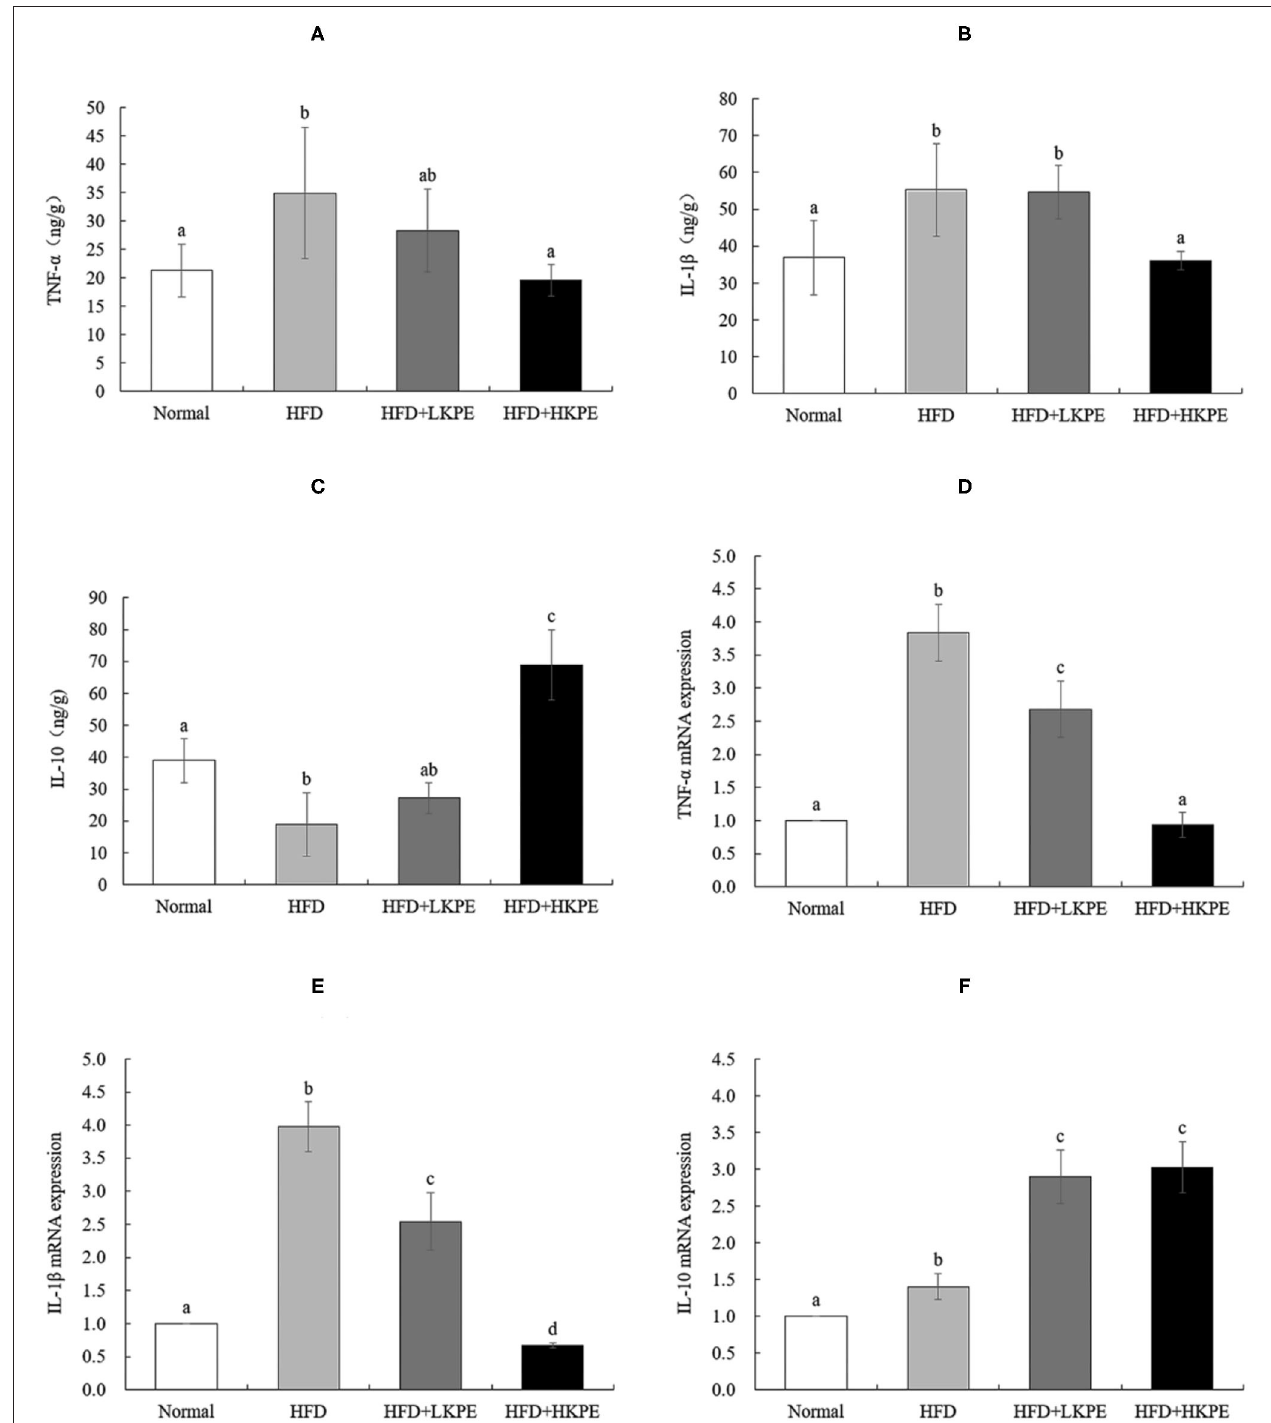
FIGURE 6 | KPE supplementation regulates the expression of intestinal inflammation cytokines. (A) The concentration of TNF- α ; (B) The concentration of IL-1 β ; (C) The concentration of IL-10; (D) The mRNA expression levels of TNF- α ; (E) The mRNA expression levels of IL-1 β ; (F) The mRNA expression levels of IL-10. Different letters (a–d) are used to express the significant difference ( p < 0.05) of the same factor among groups.